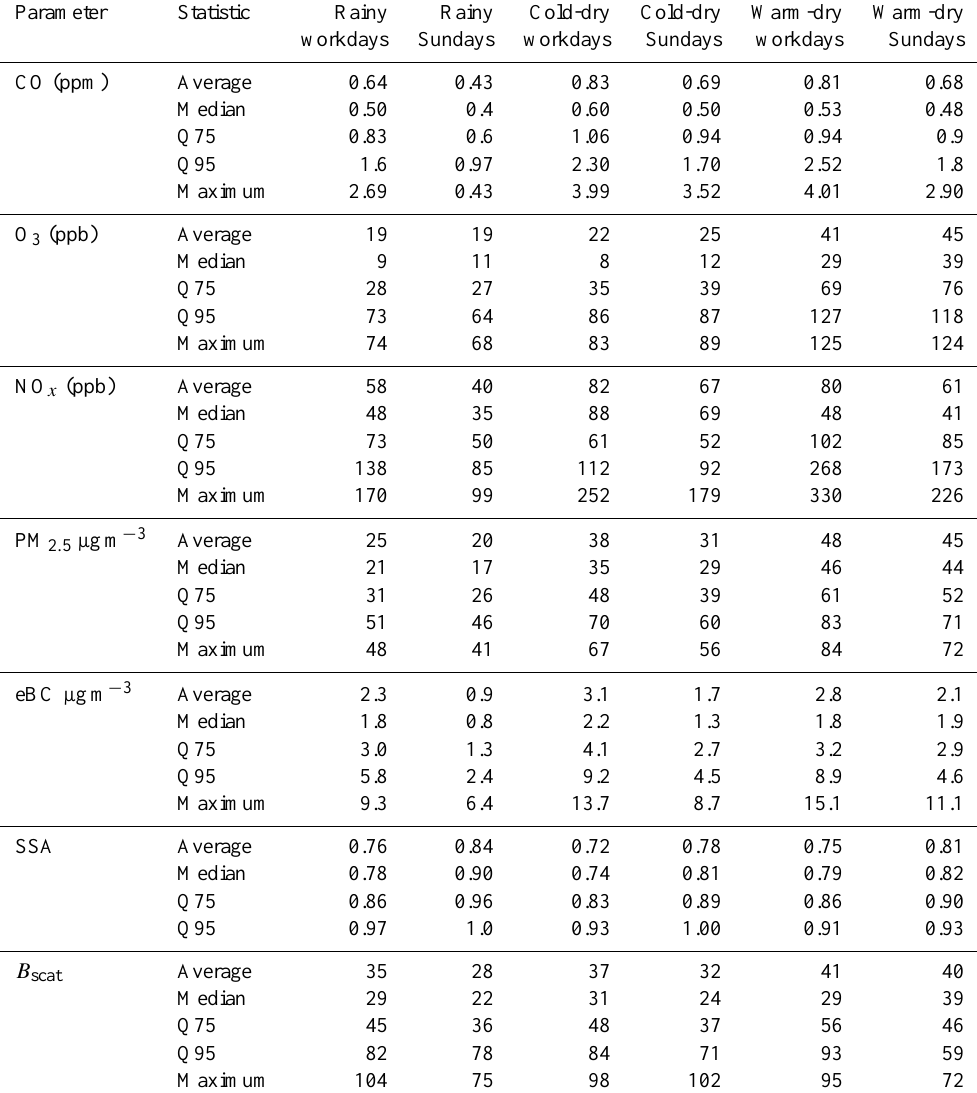
Table 1. Daily and seasonal statistics.